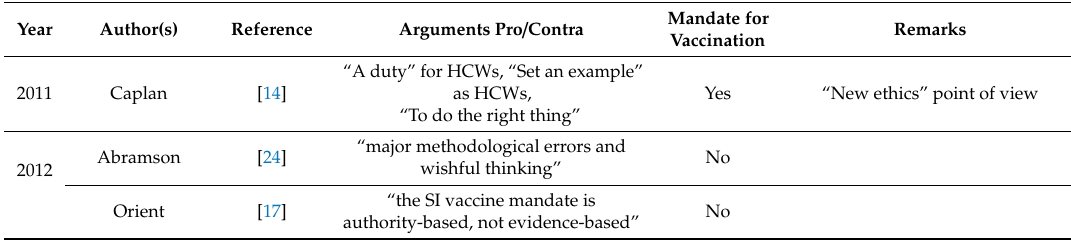
Table 1. Synthesis of publications from the 2011–2019 period regarding some arguments in favor of or against (mandatory) Seasonal Influenza (SI) vaccination of Healthcare Workers